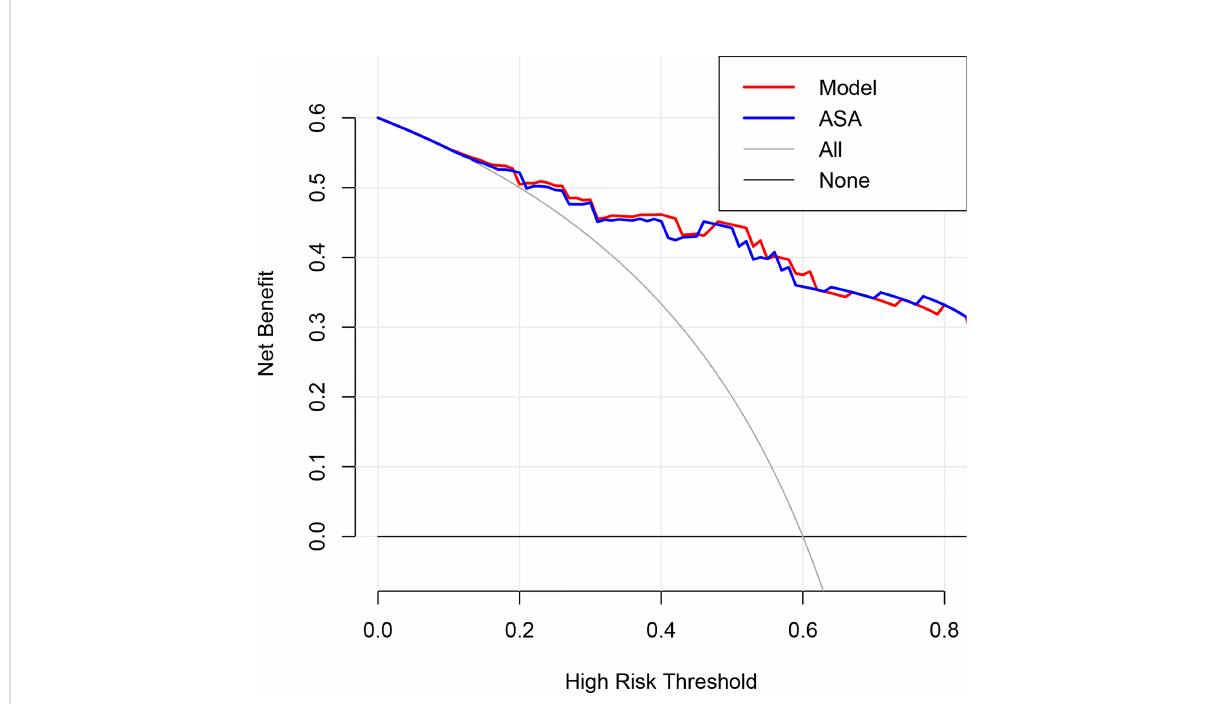
FIGURE 3 Decision curve analysis for the degree of encasement of the carotid artery and the prediction model in the validation dataset. The y-axis measures the net bene fi t, which is calculated by summing the bene fi ts (true-positive fi ndings) and subtracting the harms (false-positive fi ndings), weighting the latter by a factor related to the relative harm of undetected carotid artery invasion compared with the harm of unnecessary treatment. ASA, axial surrounding